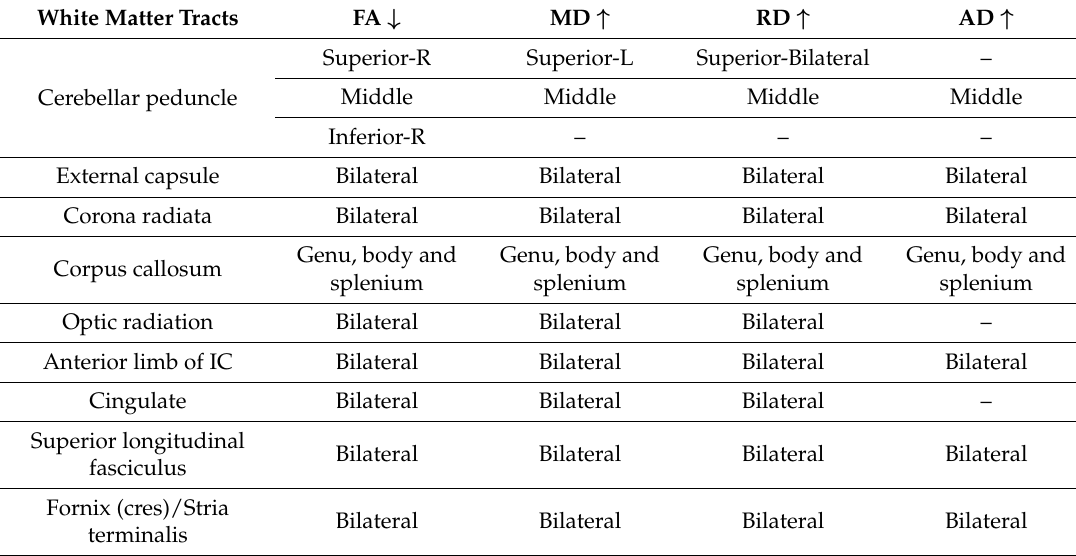
for the data, and the data are corrected using the false discovery rate (FDR). MNI = Montreal Neurological Institute; FWE = family-wise error; NA = not applicable.